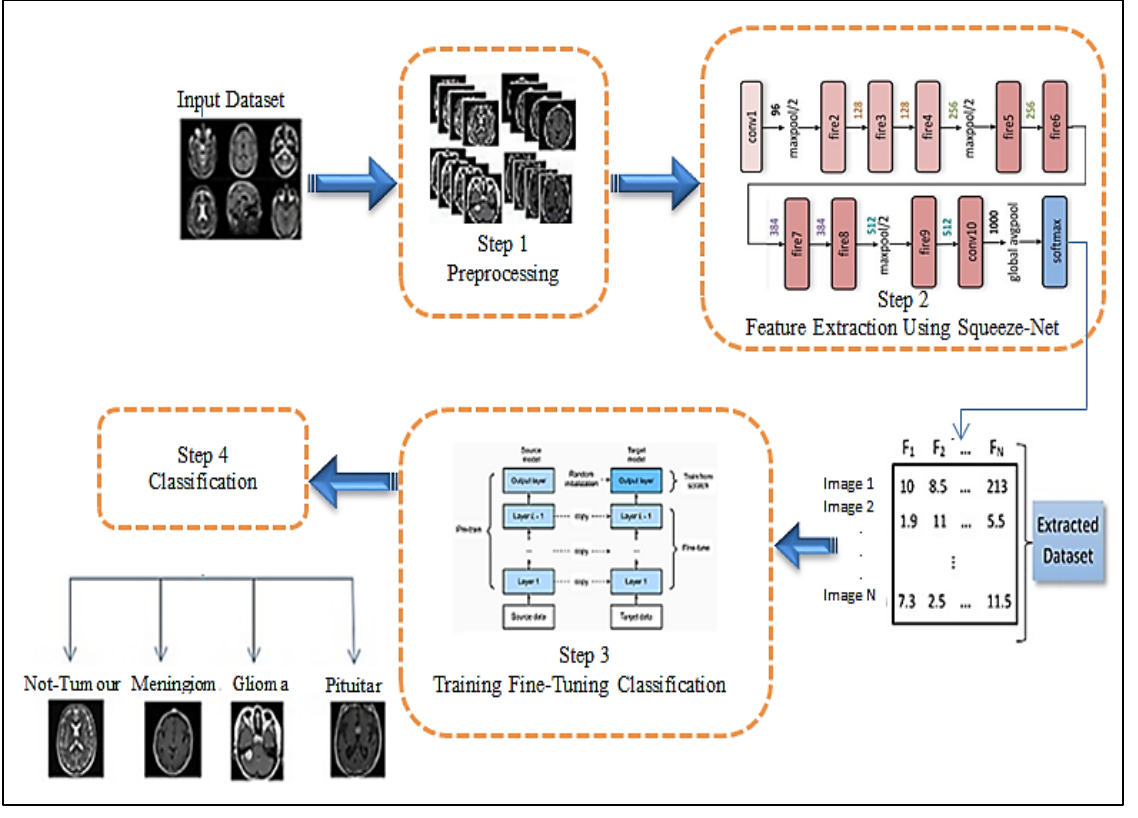
Figure 5. The finely tuned model.